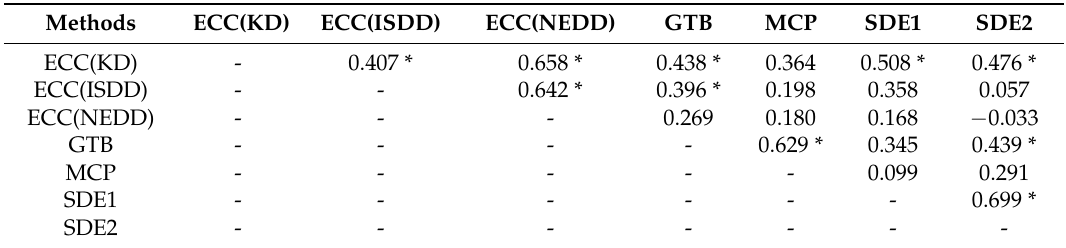
Figure A1. An example of the space ‐ time cube (aquarium). Table A1. The results of the bivariate Pearson correlation analysis between each pair of the methods for food environment exposure assessment.